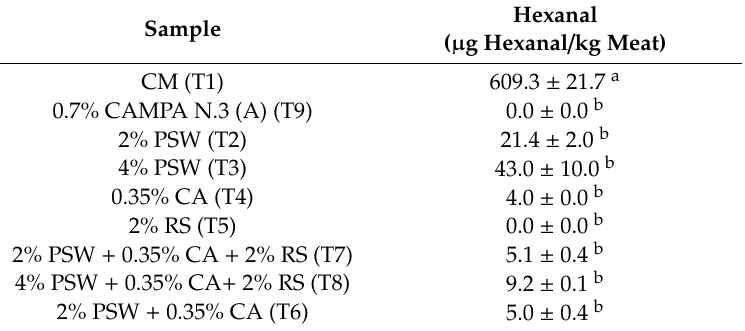
Table 5. Values of hexanal content at day 6 of the experiment.